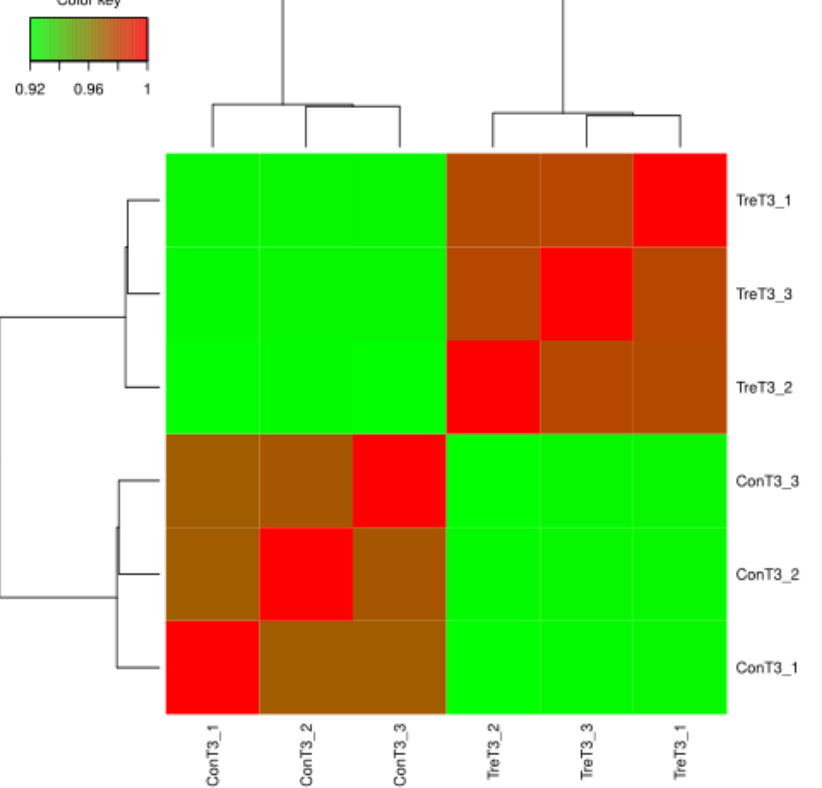
Figure 5. Correlation heat map analysis.